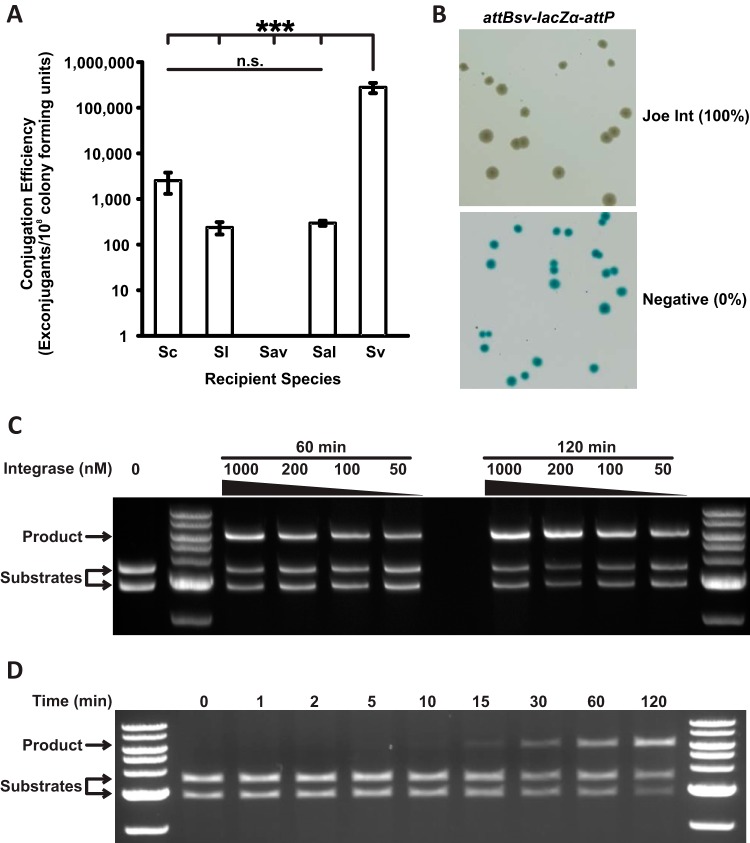
Activity of ϕJoe integrase in vivo and in vitro. (A) Conjugation efficiency of an integrating vector, containing ϕJoe int and attP, into five recipient species: Streptomyces coelicolor (Sc), S. lividans (Sl), S. venezuelae (Sv), S. albus (Sal), and S. avermitilis (Sav). Levels of significance for S. venezuelae versus all other species in a one-way analysis of variance (ANOVA) were a P value of <0.001 (3 asterisks); all other comparisons were nonsignificant (n.s.). Error bars are standard deviation (Sc, n = 5; Sv and Sl, n = 3; Sal and Sav, n = 2). (B) Representative image of an in vivo integration assay to assess attBsv-attP recombination by ϕJoe integrase (pCMF107) and a negative control (pBAD-HisA). Recombination leads to deletion of an intervening lacZα gene and white colonies, and inactivity produces blue colonies. Integration efficiency is shown in parentheses (n = 3). (C) Representative image of in vitro recombination of two substrate plasmids, attP (pCMF91) and attBsv (pCMF95), to produce the cointegrant plasmid pCMF98. The concentration of ϕJoe integrase and incubation time for each reaction are indicated above the gel. (D) Time course for the integration reaction shown in panel C.